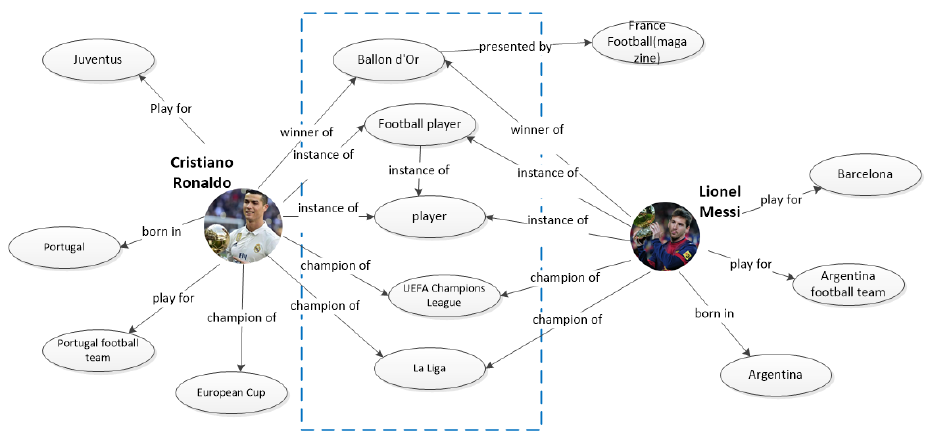
Figure 1. Illustration of C.Ronaldo and Messi connected through knowledge